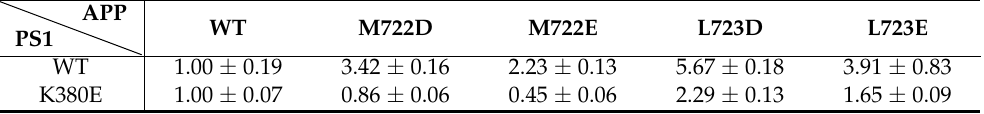
Table 2. Summary of the effects of APP aspartate and glutamate mutants. In Figure 6a,b, each APP WT was defined as one. This table indicates how many times more active the aspartate mutants (M722D and L723D) and glutamate mutants (M722E and L723E) were than the WT. The value is expressed as the average of three independent assays ± 95% confidence